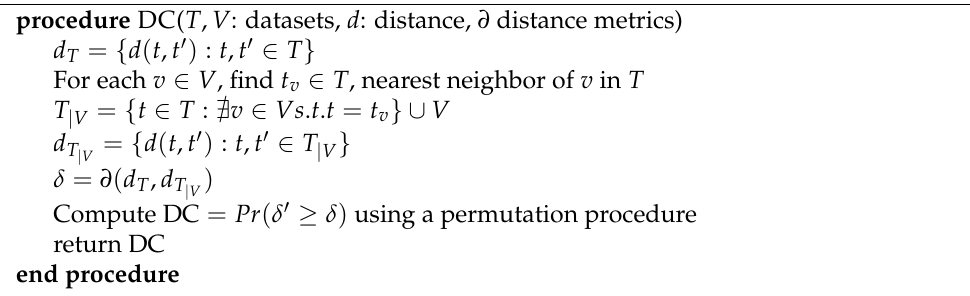
Algorithm 1 The algorithm procedure to compute the similarity between the two dataset T and V , using the Degree of Correspondence